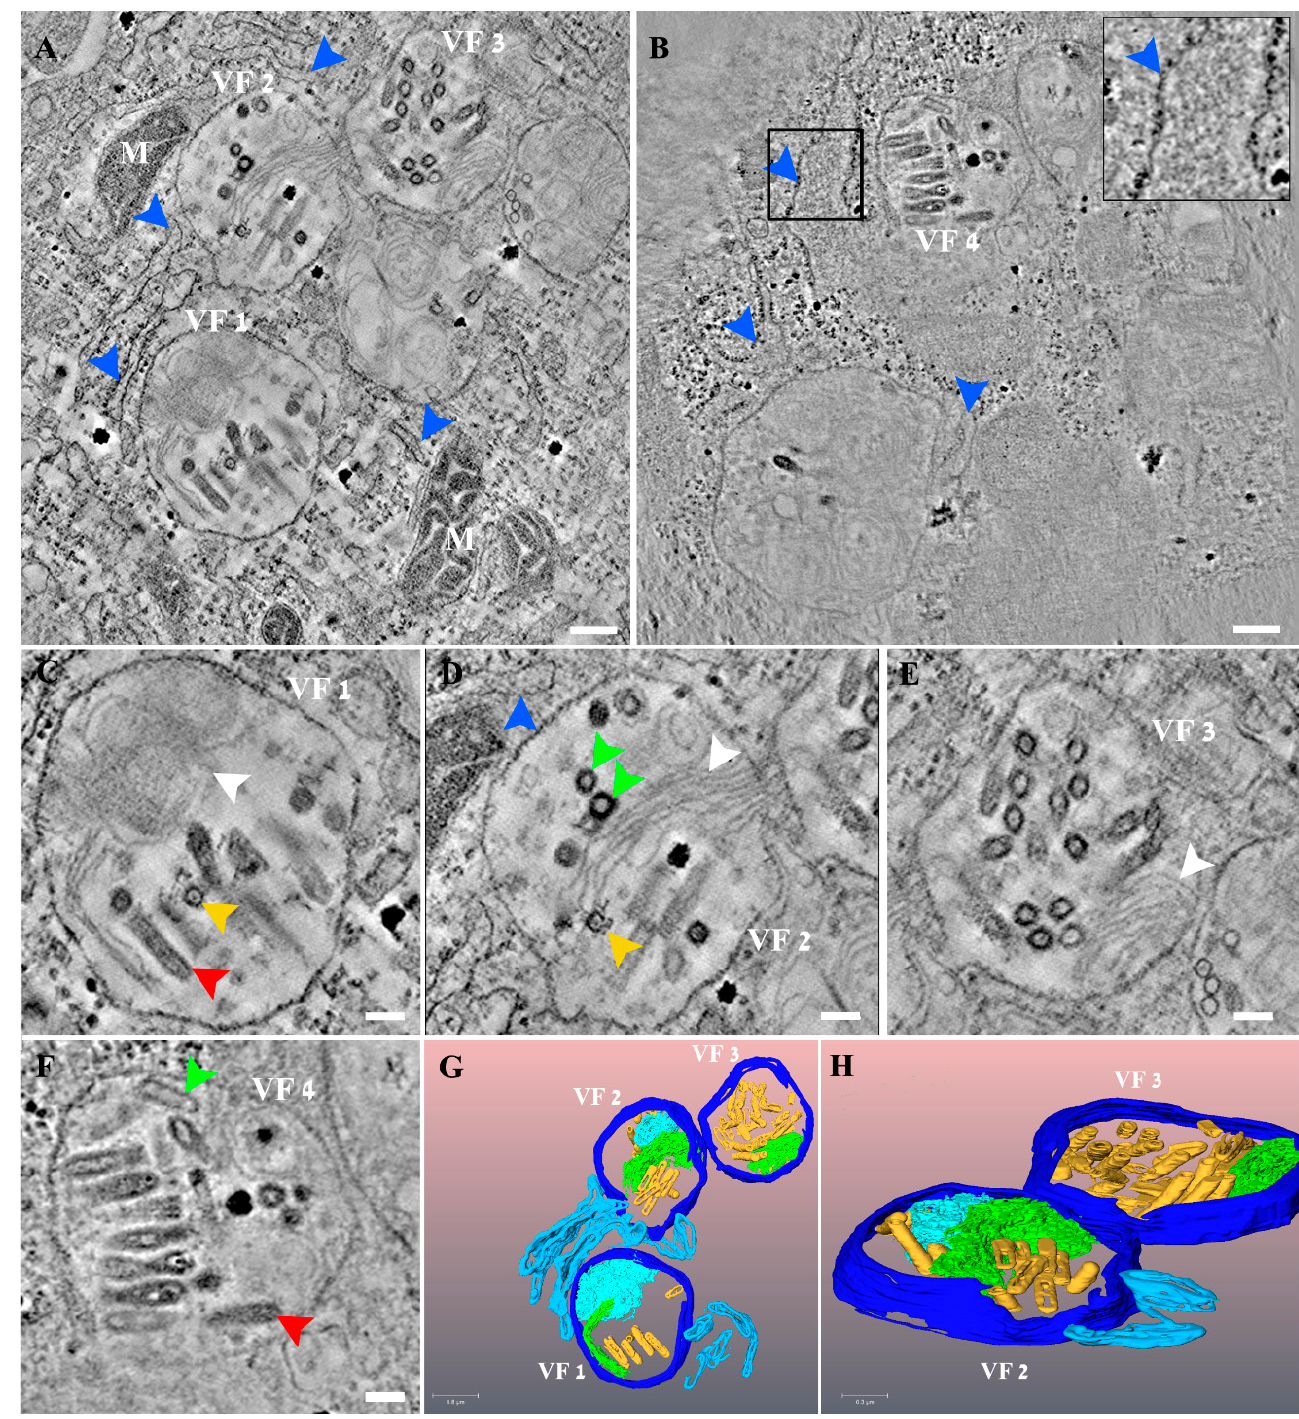
Figure 4. VSV-S viral factories (VF) are part of a complex network composed of cellular membranes and multi lamellar bodies (MLB). ( A , B ) Two tomographic slices from two different tomograms of VSV-S infected cells at 16 ( A ) and 23 ( B ) hours post infection (PI). ( C – F ) High magnification views of the VF 1–4 shown in panels ( A , B ), respectively. VSV-S VF are located in multi lamellar structures with adjacent host membrane cisternae (blue arrows and inset that shows high magnification of delineated area with host ribosomes on a membrane cisterna). The VF consist of empty particles (green arrows) as well as viruses already packed with their genome (red arrows) or other virus morphologies with partial density inside (yellow arrows). White arrows point to “onion like” membrane stacks or linear membrane sheets that are part of the MLB. ( G , H ) 3D volume rendering of the tomogram in panel ( A ) showing the MLB “onion like” composition (light blue), stack of membrane sheets (green) and adjacent membrane cisternae (light blue). Various virus morphologies of VSV-S